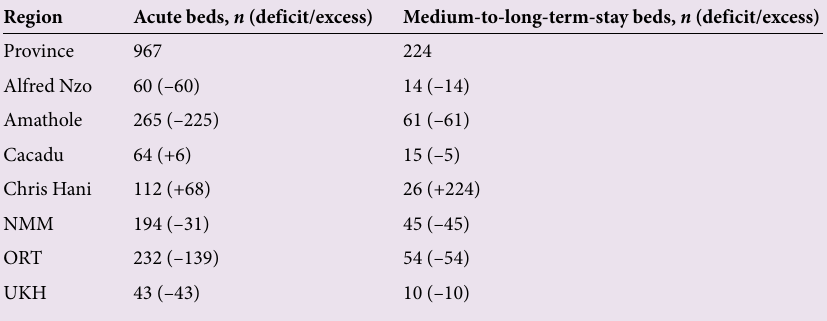
Table 6. Bed distribution requirement in the